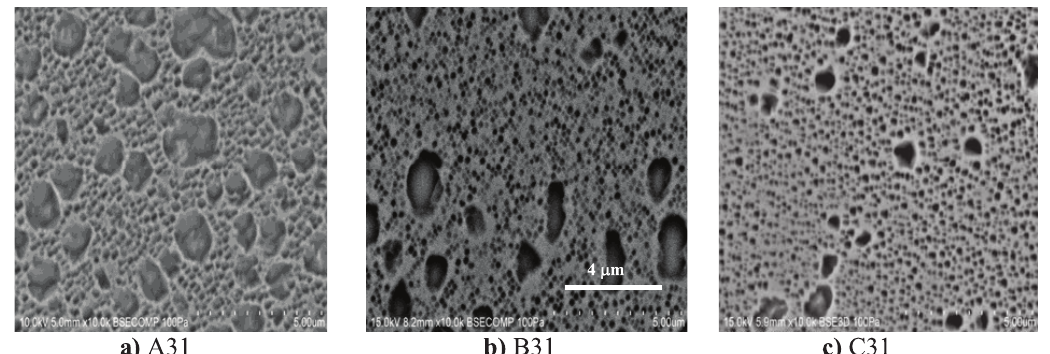
Figure 24. Microstructures of specimens after reheat treatment of Program 8.